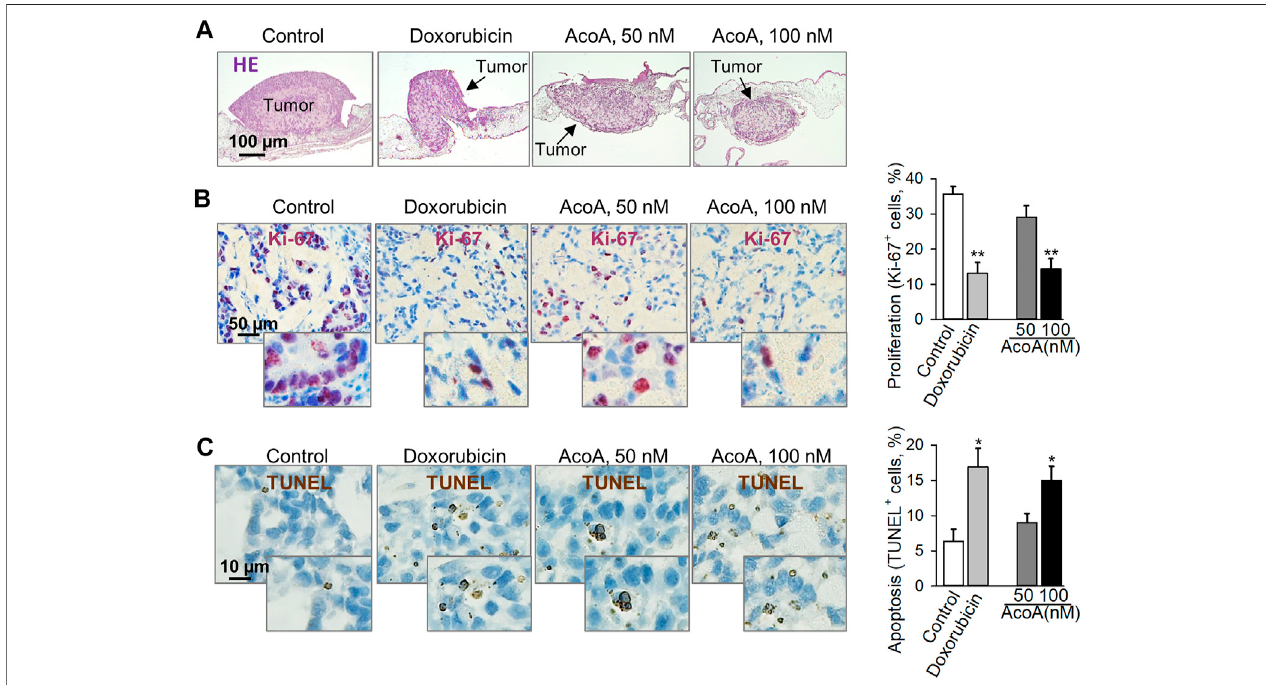
FIGURE 3 | AcoA inhibits tumor growth and induces apoptosis in A549 lung cancer xenografts on the chorioallantoic membrane of fertilized chick eggs in vivo . 1 × 10 6 A549 cells were xenotransplanted onto the chorioallantoic membrane of fertilized chick eggs 7 days after fertilization. Starting the next day, the tumors were treated with AcoA, doxorubicin, or solvent (control) for 3 days. (A) Hematoxylin and eosin staining, original magni fi cation 50x. Representative pictures are shown. (B) Immunohistochemicalanalysisoftumor cellproliferationusingnuclearKi-67antigen(proliferationmarker,darkviolet).Nucleiwerecounterstainedwithhematoxylin